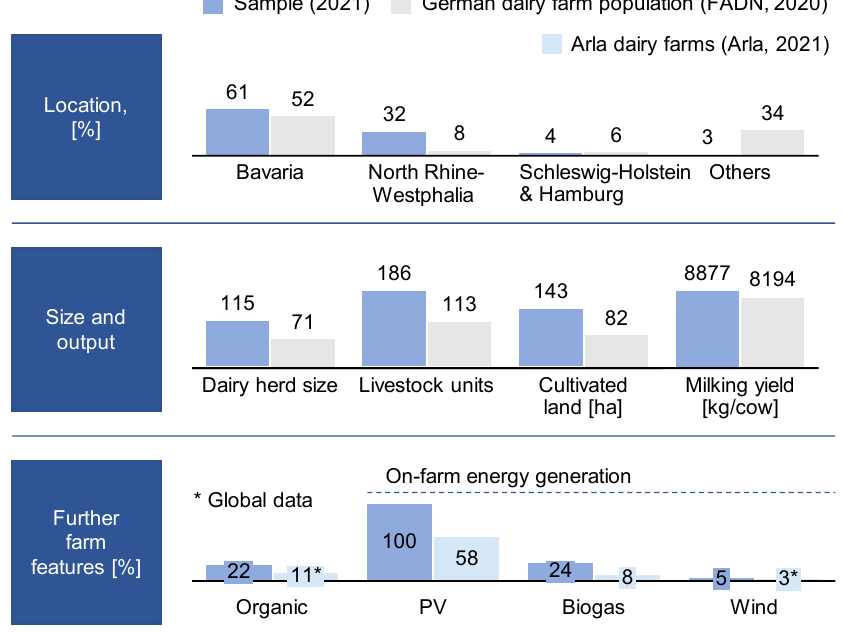
Figure 1. Farm characteristics of the survey sample compared to data from [23,24].